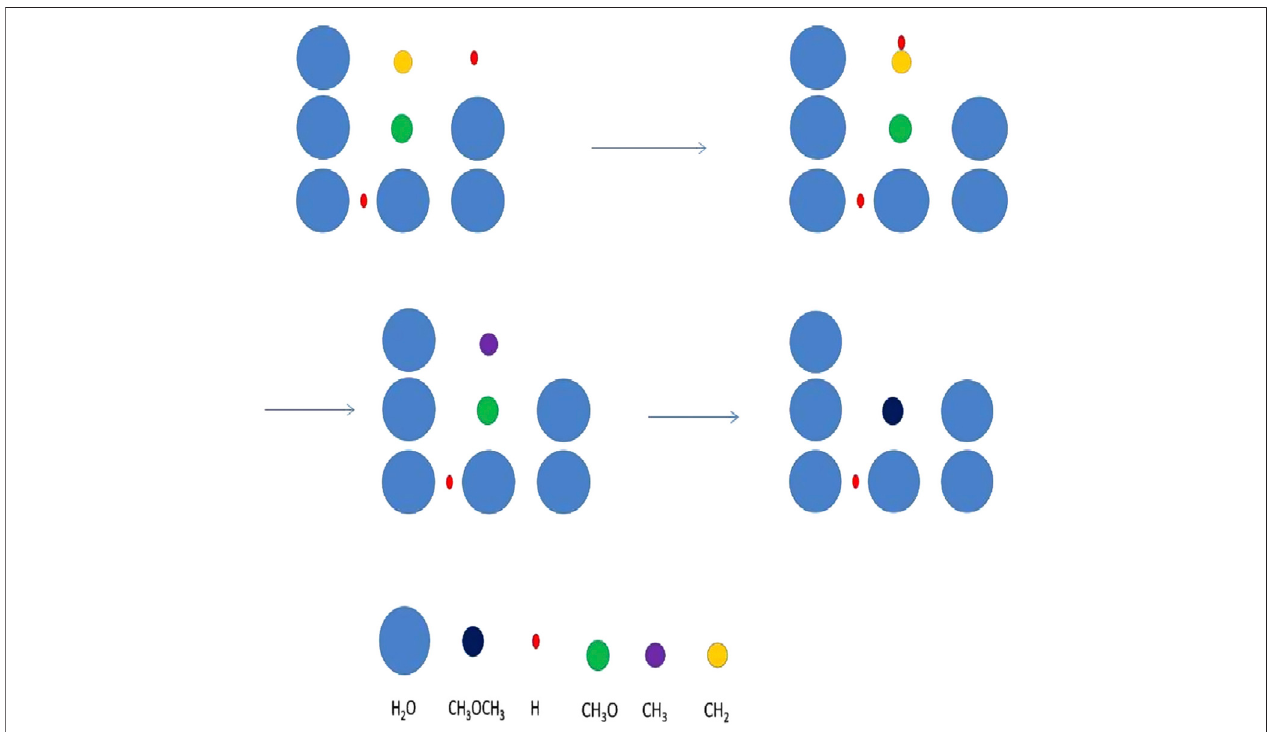
FIGURE 4 | A mechanism of stochastic surface motions leading to the formation of dimethyl ether. The mechanism is labelled three-body motion or a chain reaction,andhereconsistsofadiffusiveandashortdistancenondiffusivemotion.TheprocesscommenceswhenHandCH Figure reproduced from Figure 1 of Chang and Herbst